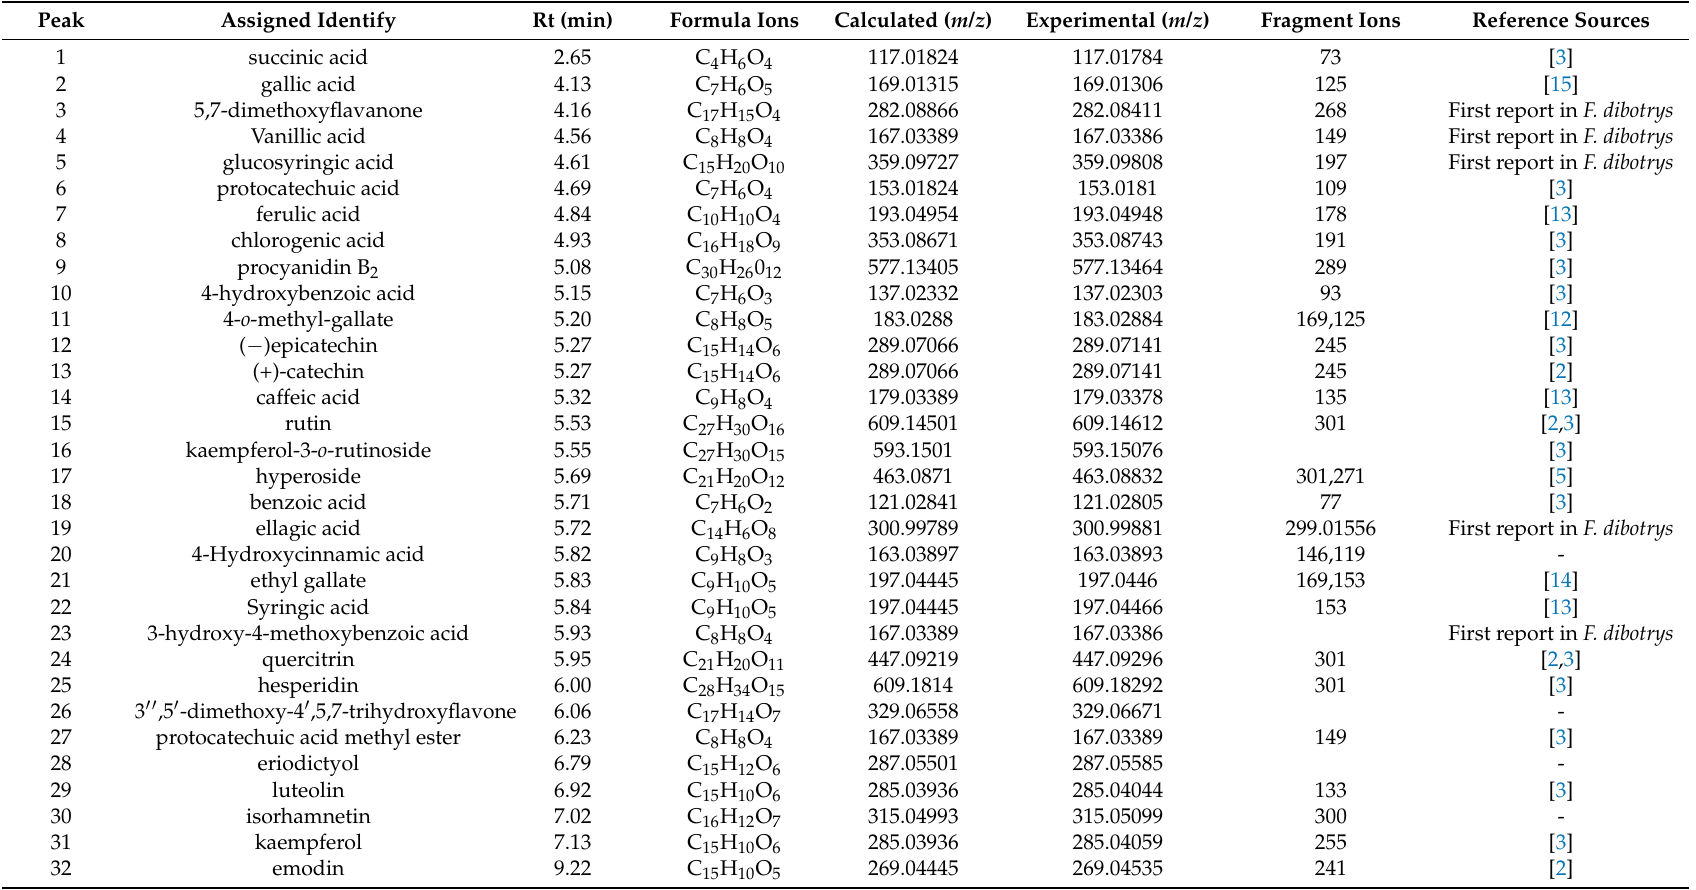
Table 1. Thirty-two chemical constituents identified in the ethyl acetate fraction (EA) of F. dibotrys extracts using